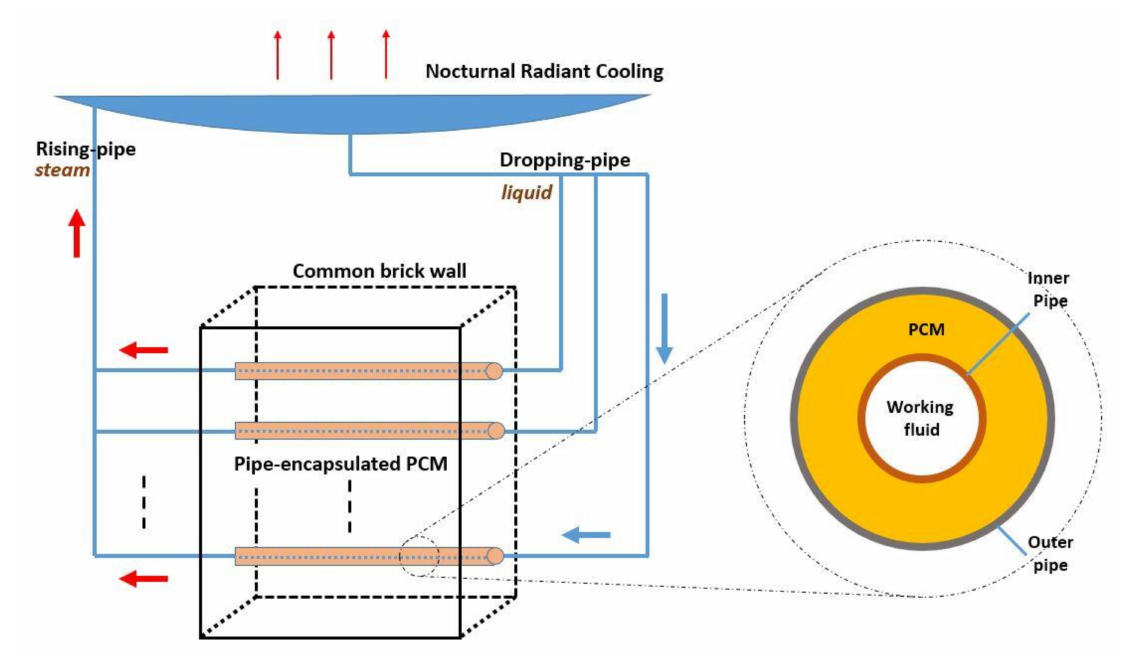
Figure 11. Novel self-activated PCM wall mechanism